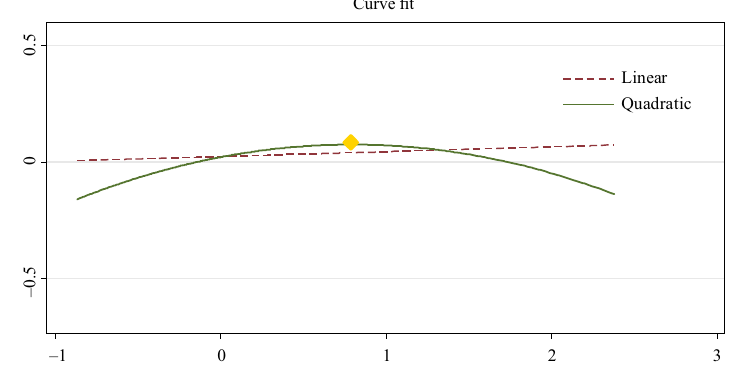
Fig. 1. Curve estimation regression models between ROA and